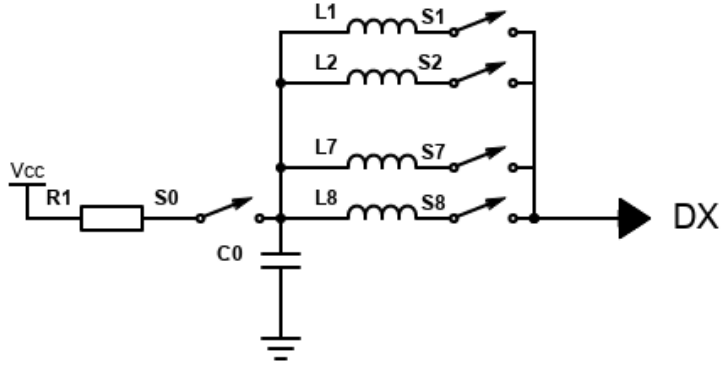
Figure 4. schematic of pulse